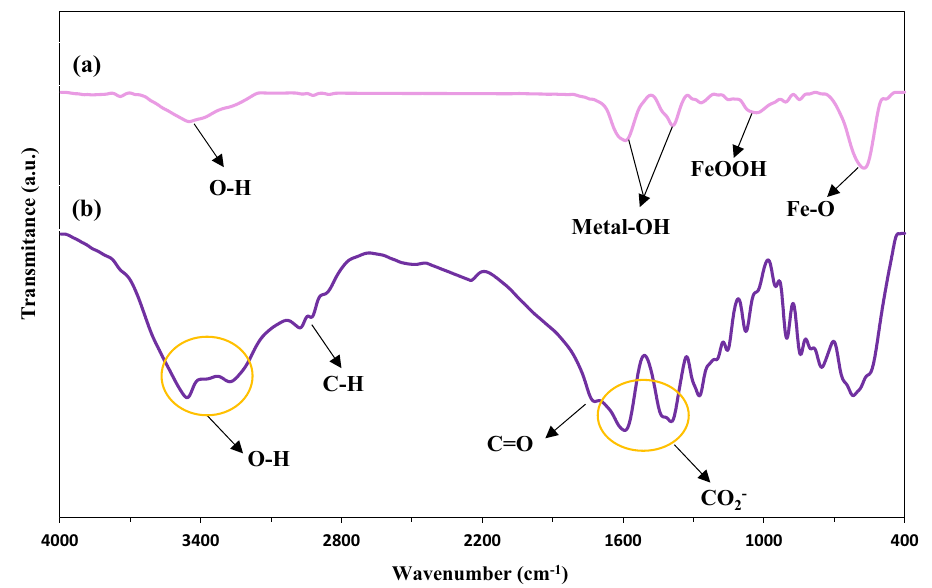
Figure 3. FT-IR spectrum of ( a ) CuFe 2 O 4 @CQD, ( b ) CQDs of citric